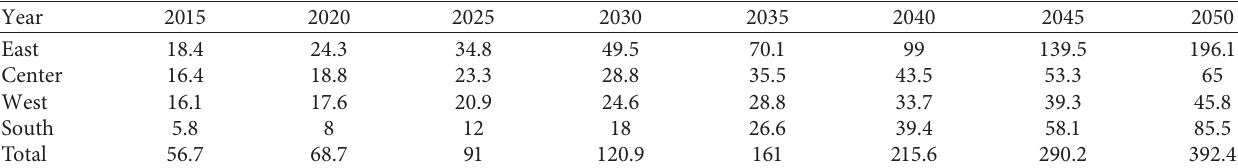
Table 6: The projected electricity peak demand of Saudi Arabia predicted in this study